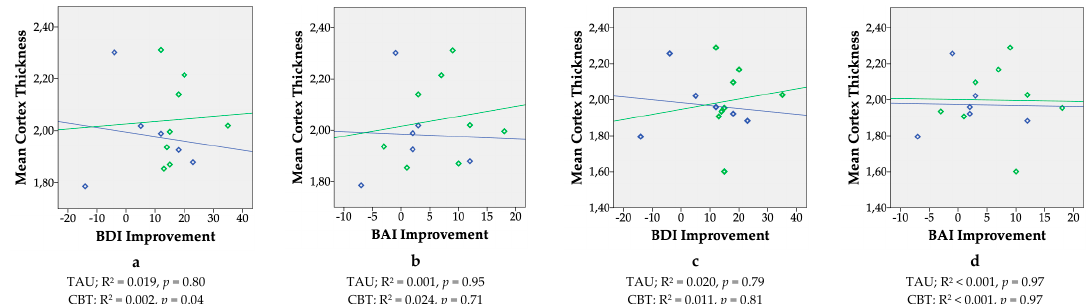
Figure 4. Scatterplots showing correlations between changes in maternal mood symptoms during pregnancy regardless of treatment status (defined as the difference in symptom score of the Beck Depression Inventory (BDI-II) and the Beck Anxiety Inventory (BAI) before and after treatment in a longitudinal study in children built on a pilot Randomized Controlled Trial, comparing maternal antenatal Cognitive Behavioral Therapy (CBT, n = 8) to Treatment as Usual (TAU, n = 6)) and cortical thickness of the children’s brain, approximately six years postpartum. Regions shown are the mean cortex thicknesses of the left (a & b) and right (c & d) hemisphere. X-axis: BDI = Beck Depression Inventory, BAI = Beck Anxiety Inventory. Higher scores indicate a better response to treatment. Y-axis: Mean Cortex Thickness Ratio = ((mean average cortex thickness (mm))/estimated Total Intracranial Volume(mm)) * 1,000,000. Green diamonds and slope = CBT, blue diamonds and slope = TAU.